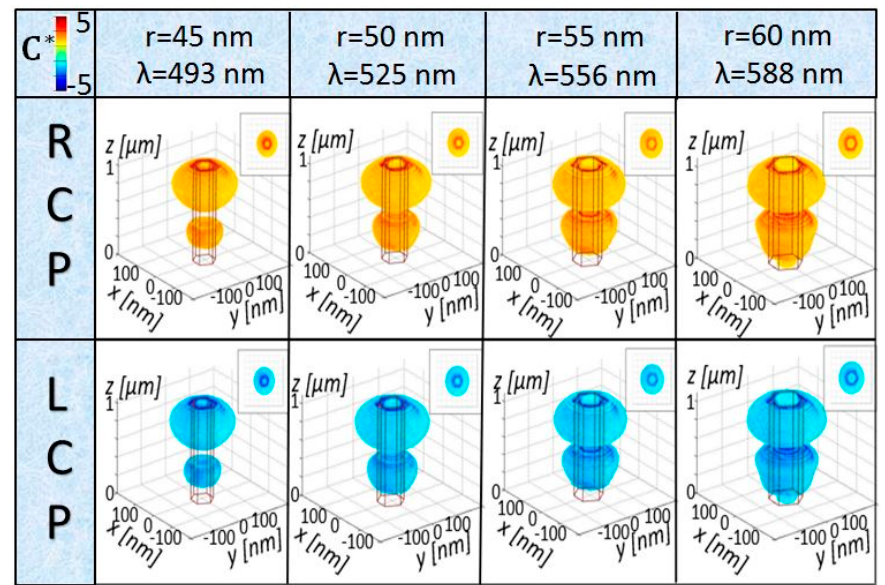
Figure 2. C* distribution in the unit cell for p = 400 nm, L = 1000 nm, and r = 45–60 nm, at the corresponding NW resonant wavelength for RCP (upper, positive) and LCP (bottom, negative) excitation. The insets show the xy top view of each C* distribution.